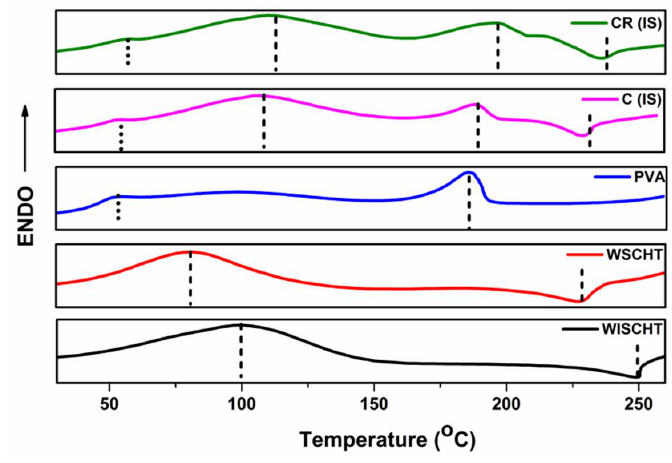
Figure 6. Differential Scanning Calorimetry (DSC)of prepared samples.